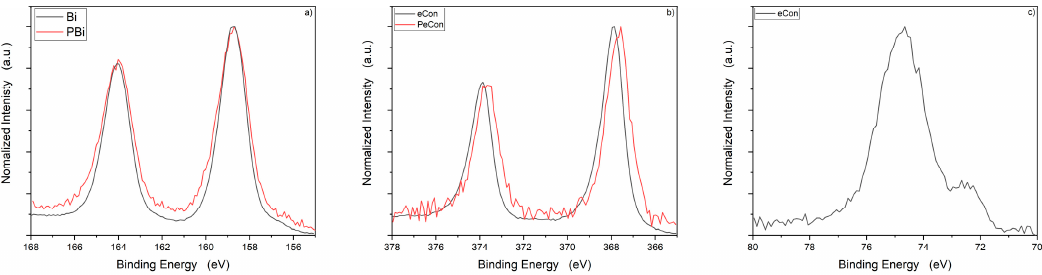
Figure 3. X-ray photoelectron spectroscopy (XPS) detail spectra of reference, polyester and CSs coated beech carbon ( a ) and oxygen ( b ). Figure 4. XPS detail spectra of ( a ) bismuth, ( b ) silver and ( c ) aluminum of beech coating.